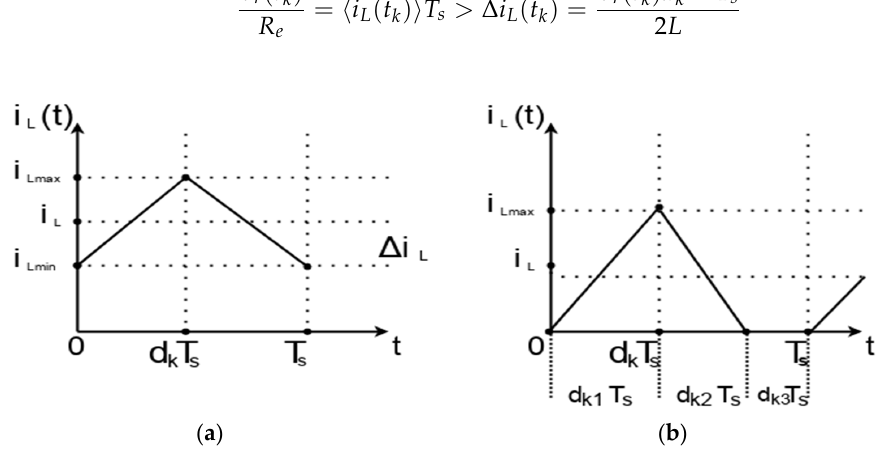
Figure 2. Inductor current waveform: ( a ) in CCM mode; ( b ) in DCM mode.